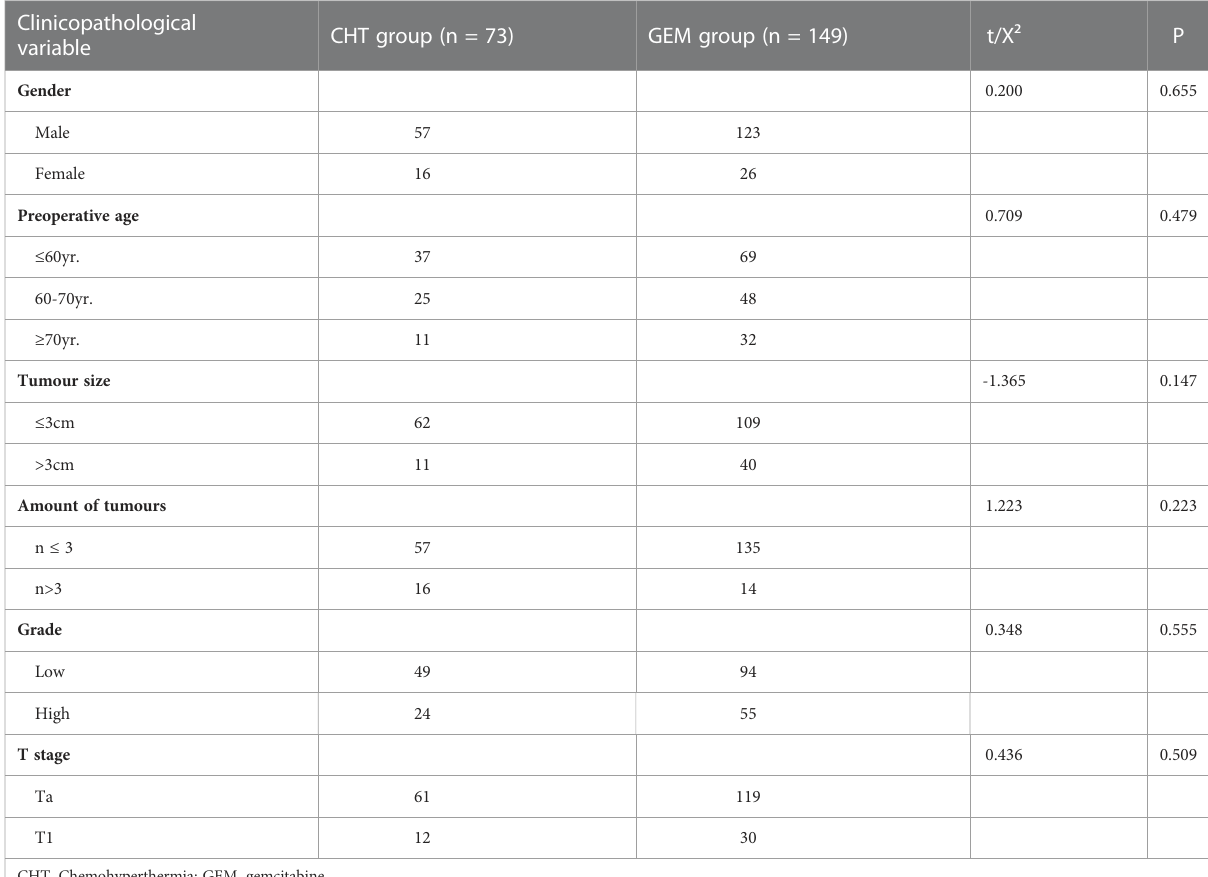
TABLE 1 Clinicopathological data of patients with NMIBC between the GEM group and the CHT group.